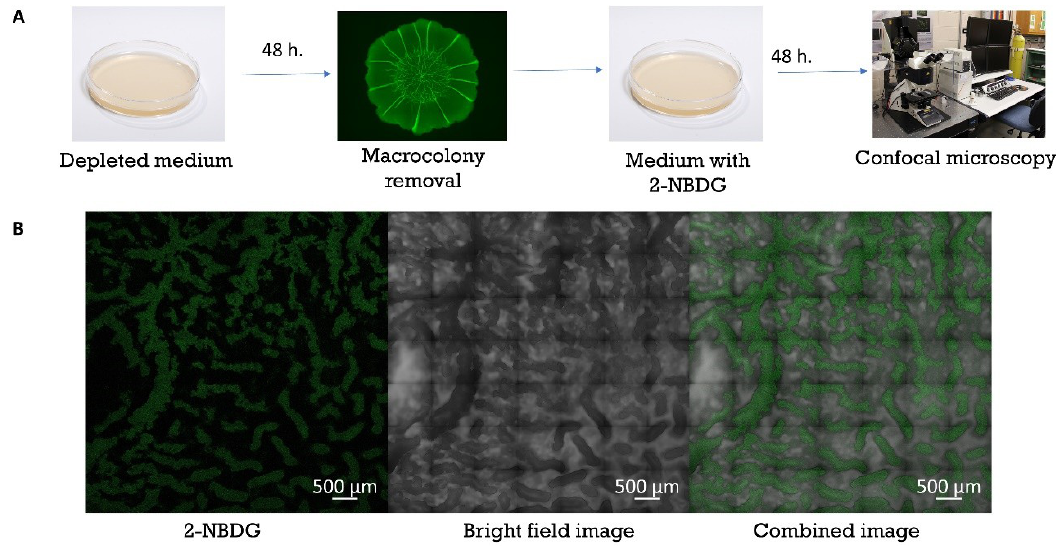
Figure 5. Co-localization of 2-NBDG within channels. ( A ) Experimental design – colony type biofilms, grown to maturation (48 h) on solid mediums with 50% LB content were moved onto growth mediums supplemented with 2-NBDG. Confocal images in ( A ) were taken after an additional period of 48 h; ( B ) Green signal (left) demonstrates the localization of the fluorescent tracer 2‐NBDG within the interior of channels (seen as darker areas in the bright field image, right).